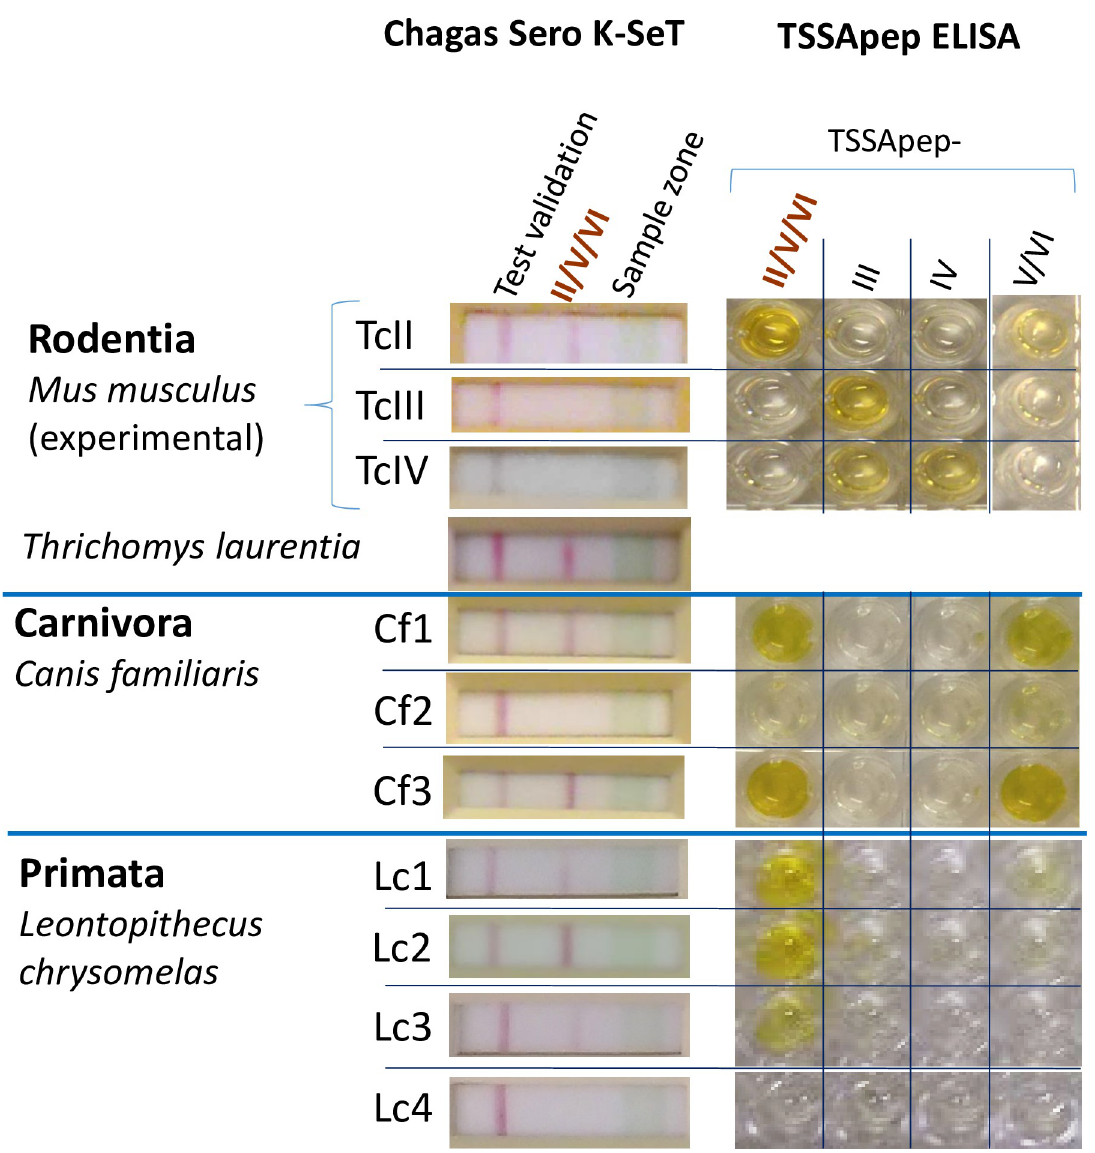
Fig 2. Concordance of TSSApep ELISA and Chagas Sero K -Set across mammalian Orders. Representative samples from experimental T . cruzi murine infections and natural infections of Thrichomys laurentius (Rodentia: Echimyidae), Canis familiaris (Carnivora: Canidae) and Leontopithecus chrysomelas (Primata: Callitrichidae). For primate samples, Kappa test = 0.84, 95% confidence intervals (0.64–1.00). Sample Lc4 was T . cruzi seronegative. The T . laurentius sample shown here did not have a corresponding